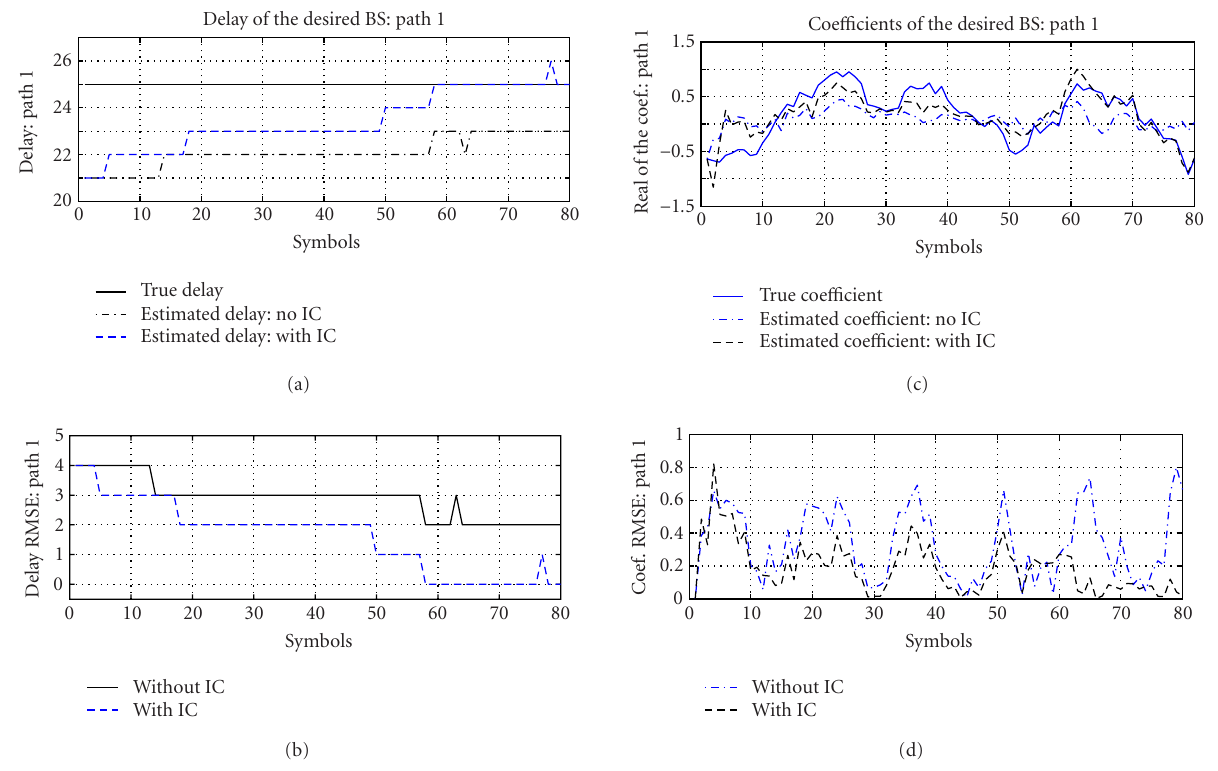
Figure 3: EKF-based desired BS estimation for four closely spaced paths, N BS = 4, N u = 8, E b /N 0 = 10dB, S F = 256, and N s = 8.